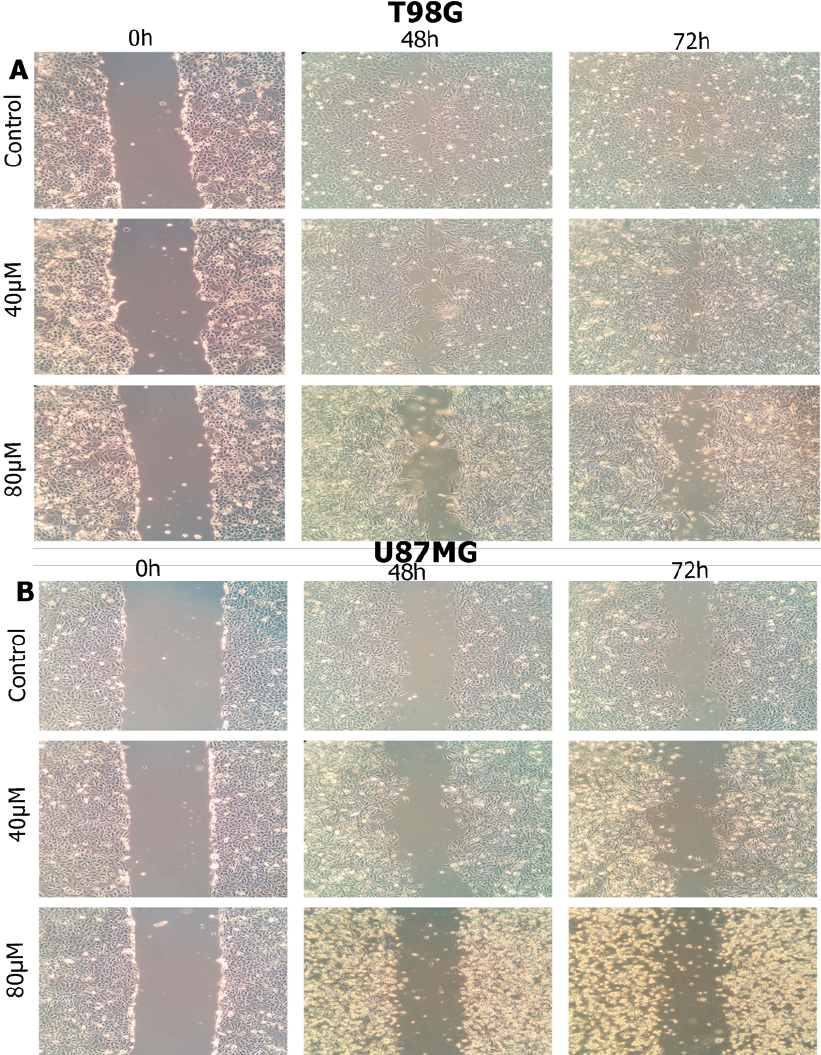
Figure 5. The influence of haloperidol on the migratory ability of glioblastoma cells at 48 and 72 h. ( A) : T98, ( B ): U87, ( × 40). Approximately 100,000 cells were seeded in 6-well plates; when the cells